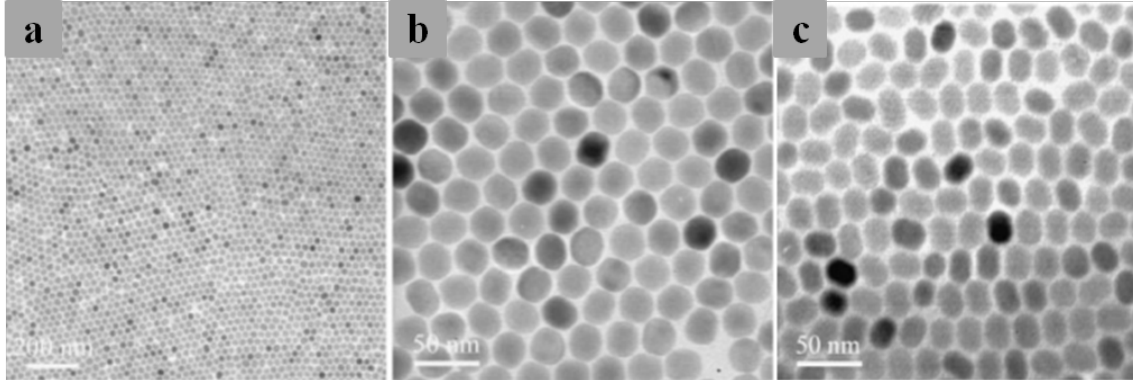
Figure 2: Control of nanocrystal shape. a–b) TEM images of NaYF 4 :Yb, Er nanospheres at different magnifications. c) TEM images of NaYF 4 :Yb, Er nanoellipses [21].